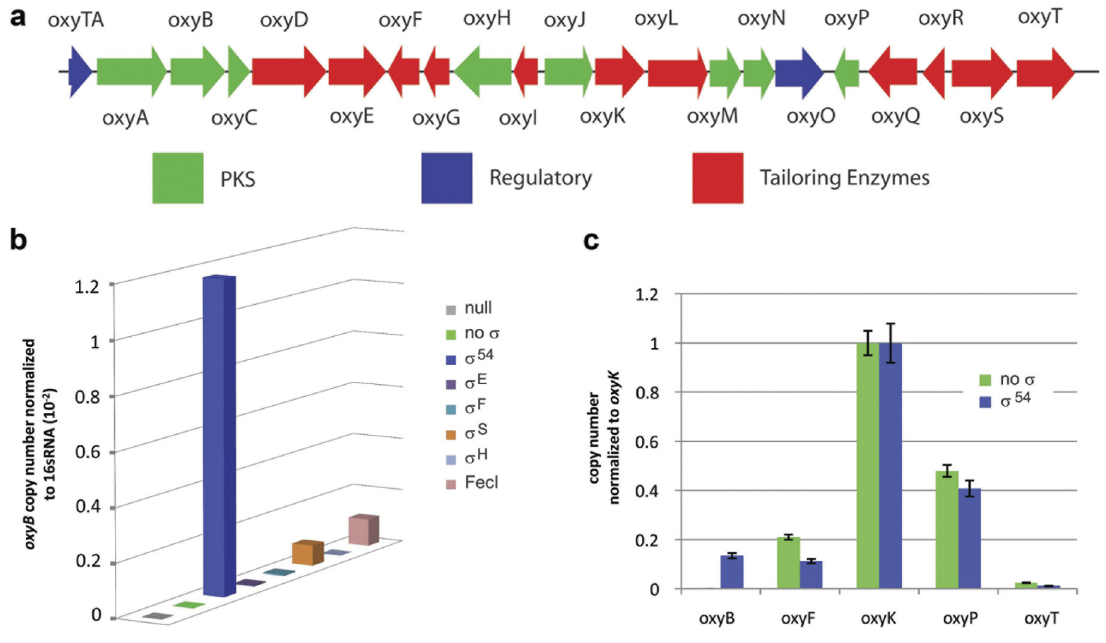
Figure 1. SYBR-green based qPCR analysis shows that transcription limits heterologous production of oxytetracycline in E.coli . ( a ) The 32 kb oxytetracycline biosynthetic gene cluster is shown. Five putative operons, oxyABCDE , oxyIHGF , oxyJKLMNO , oxyRQP , and oxyST are predicted for this gene cluster ( b ) qPCR analysis shows that over-expression of the alternative sigma factors s 54 , s S and FecI enable detectable levels of the oxyB transcript to be produced. Over-expression of no sigma factor, s E , s F and s H do not lead to detectable levels of the oxyB transcript. ( c ) qPCR analysis shows that over-expression of the alternative sigma factor s 54 lead to detectable levels of transcripts for all five putative operons in the oxytetracycline biosynthetic pathway. In the absence of s 54 over-expression, the oxyB transcript cannot be detected. See also Table S1. No oxyB, oxyF, oxyK, oxyP, oxyT transcripts were observed in the null strains which lacked the oxytetracycline gene cluster. (Figures S1, S2).